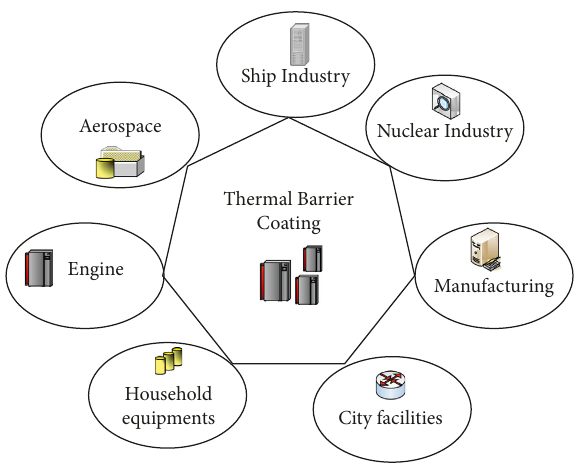
Figure 1: Application fields of thermal barrier